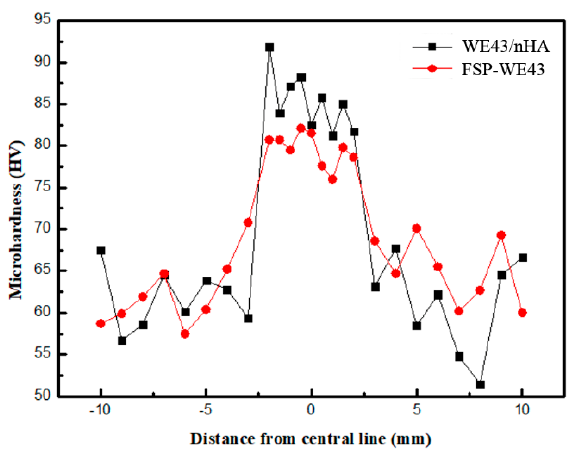
Figure 6. Microhardness distribution curves of WE43/nHA and FSP-WE43 specimens.